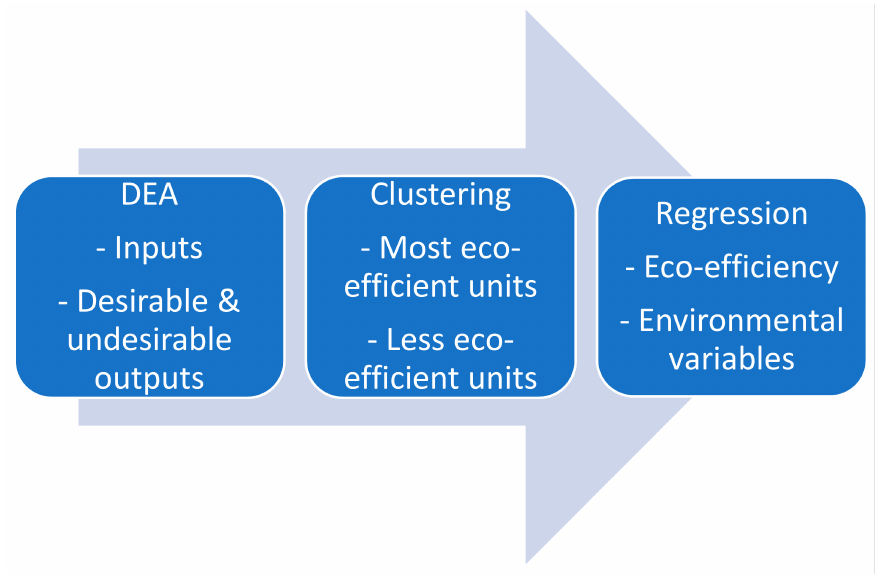
Figure 1. Eco-performance measurement of water utilities in our